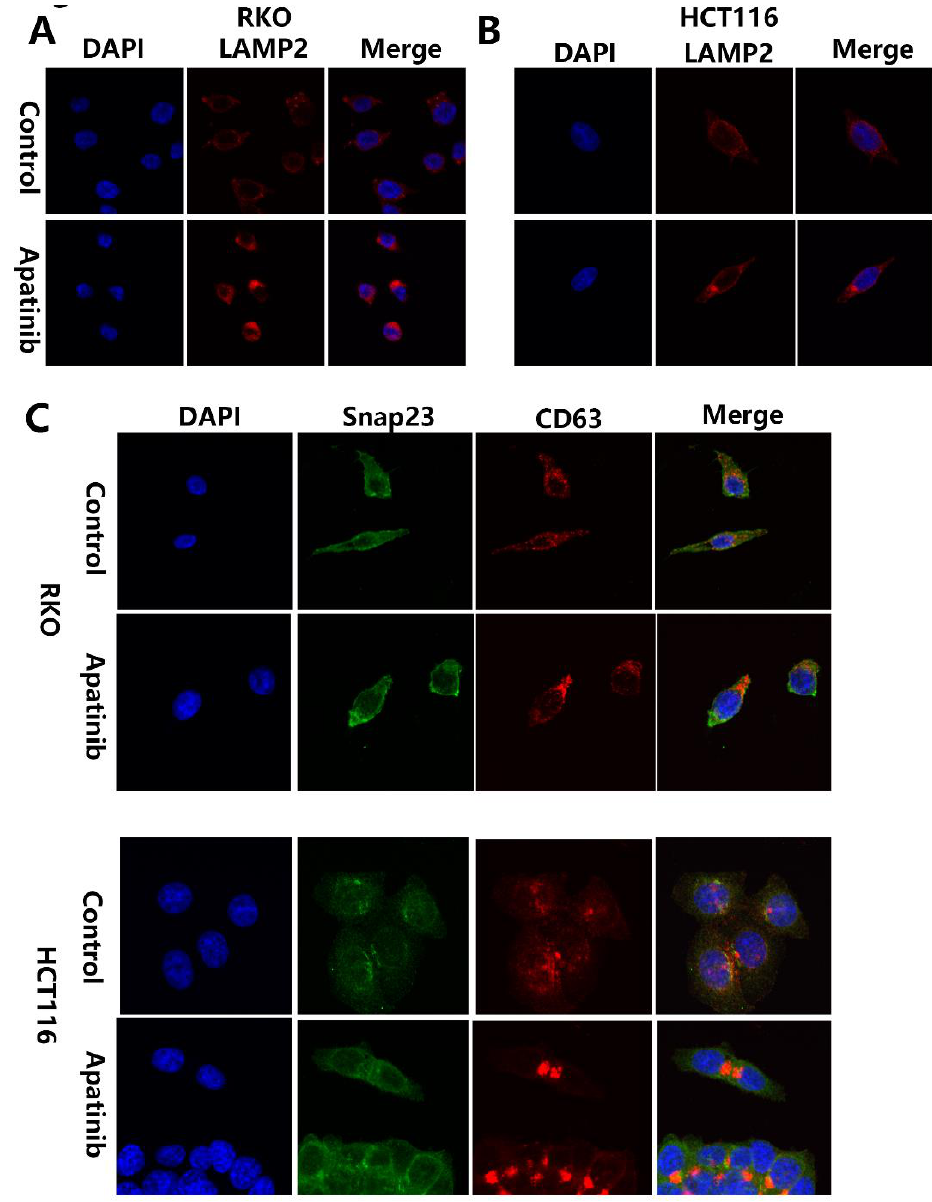
Figure 7. Apatinib regulates the localization of LAMP2 and colocalization of Snap23 with CD63. ( A , B ) Immunofluorescence of the LAMP2 (red) distribution in RKO and HCT116 cells with or without apatinib treatment. ( C ) Confocal colocalization analysis of CD63 (red) and SNP23 (green) in RKO and HCT116 cells with or without apatinib treatment.